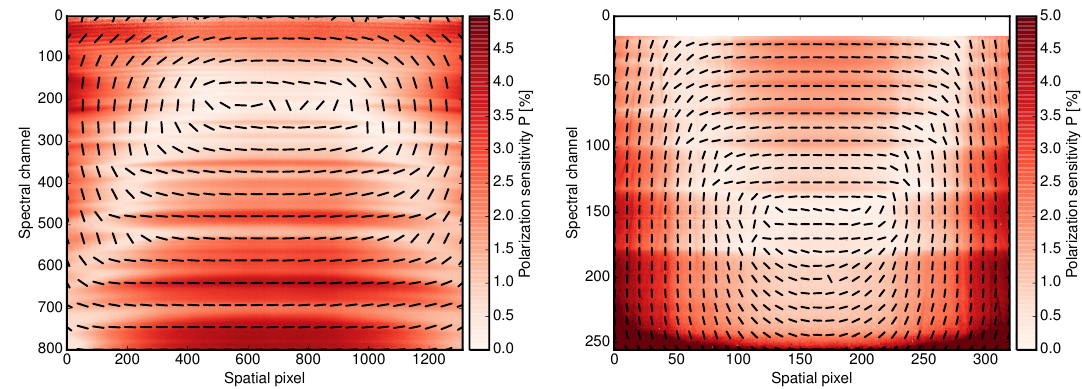
Figure 15. Results of the polarization sensitivity characterization for the VNIR (left) and the SWIR (right). The color map shows the polarization sensitivity P for all pixels as determined with Eq. (17). With the entrance slit oriented horizontally to this figure, the black solid lines indicate the polarization orientation for which the signal becomes